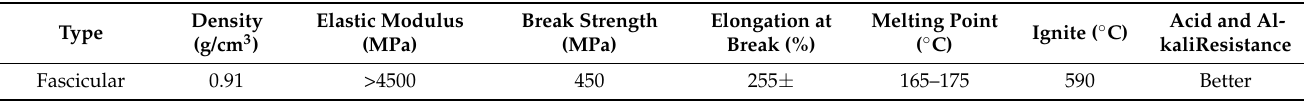
Figure 2. Physical and microscopic pictures of polypropylene fibers: ( a ) physical map, ( b ) micrograph. Table 1. Physical indicators of polypropylene